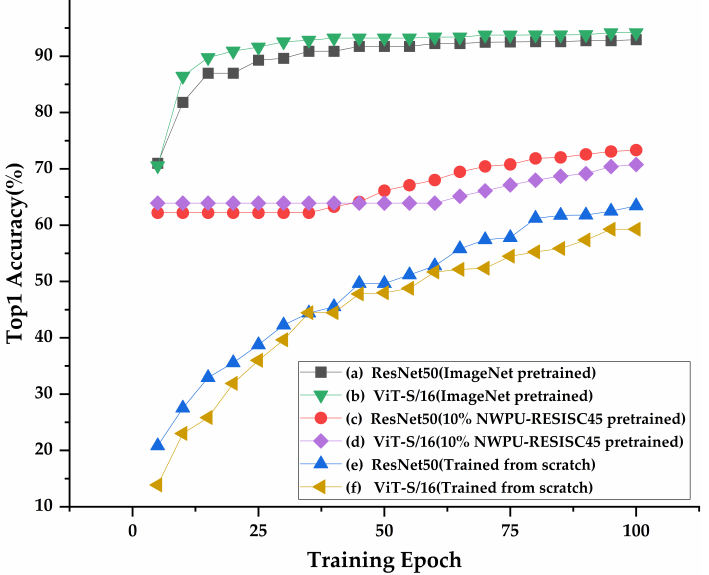
Figure 2. Top1 accuracy of ViT-S/16 and ResNet50 under different initialization.